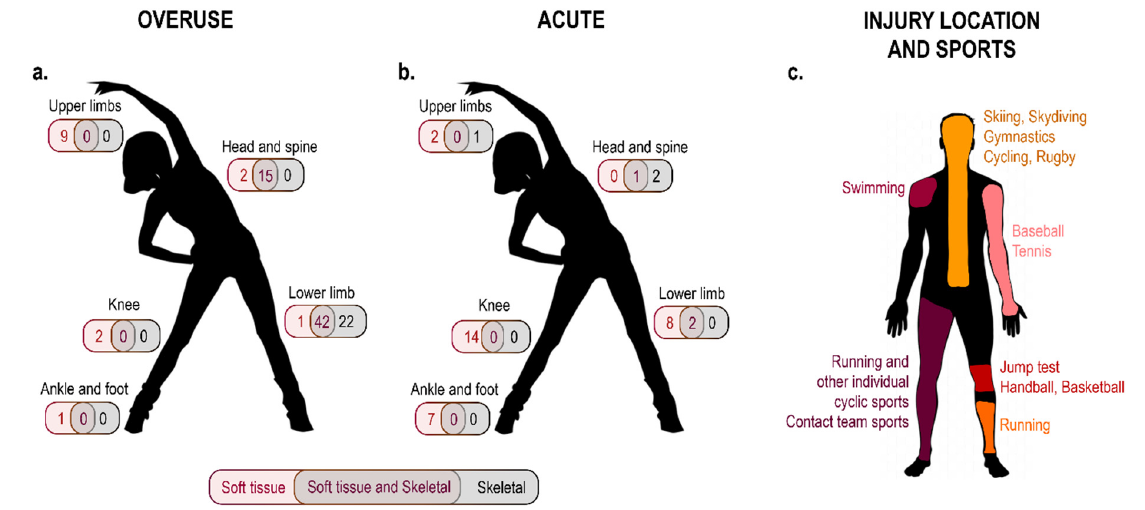
Figure 5. ( a , b ) Breakdown of studies (absolute number) by injury location (i.e., ankle and foot, knee, lower limb, head and spine, upper limb), tissue affected (i.e., soft or skeletal), and injury type (acute or overuse). Articles in which the body region was not specified, or considering any injury location, along with articles including both acute and overuse injuries, are not reported in the figure (34 studies in total). ( c ) Body map showing injury location and the associated sports disciplines for which there is prevalence of published research in the areas considered by this review.